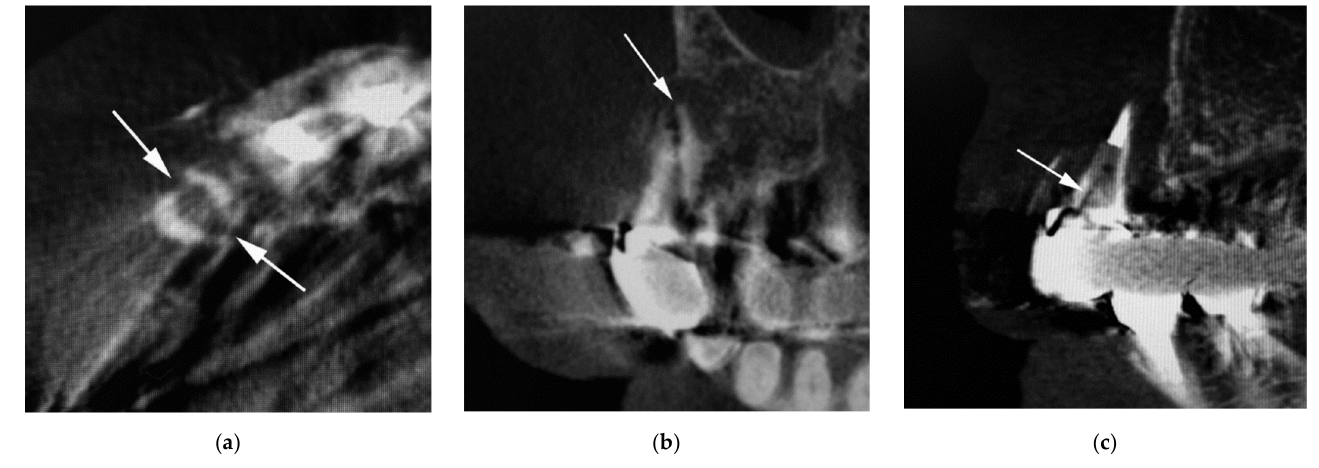
Figure 1. Cone-beam computed tomography (CBCT) image of vertical root fractures in endodontically treated teeth (bucco-lingual fracture). ( a ) Axial image; ( b ) cross-sectional multiplanar reformation (MPR) image; and ( c ) parasagittal MPR image. Arrow indicates part of root fracture.